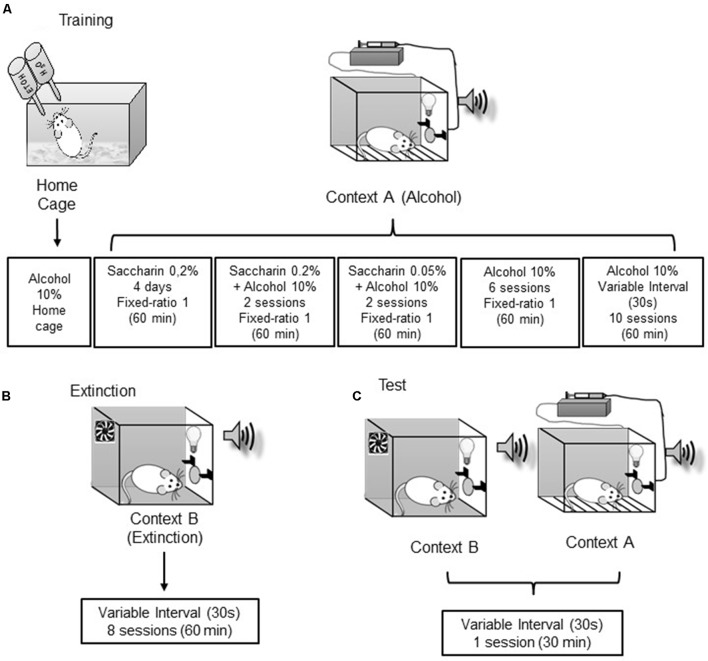
Schematic representation of the experimental design. The protocol was adapted from Willcocks and McNally (2013). Briefly, rats were given access to 10% ethanol in their home cages. Using a saccharin fading technique, rats are trained to self-administer 10% ethanol in context A. Subsequently, the lever pressing in the presence of the discrete cue was extinguished in context B. The context-induced reinstatement of drug seeking was assessed by re-exposing the rats to context A or B under extinction conditions. See Methods for more details. (A) Training phase; (B) Extinction phase; (C) Test day.